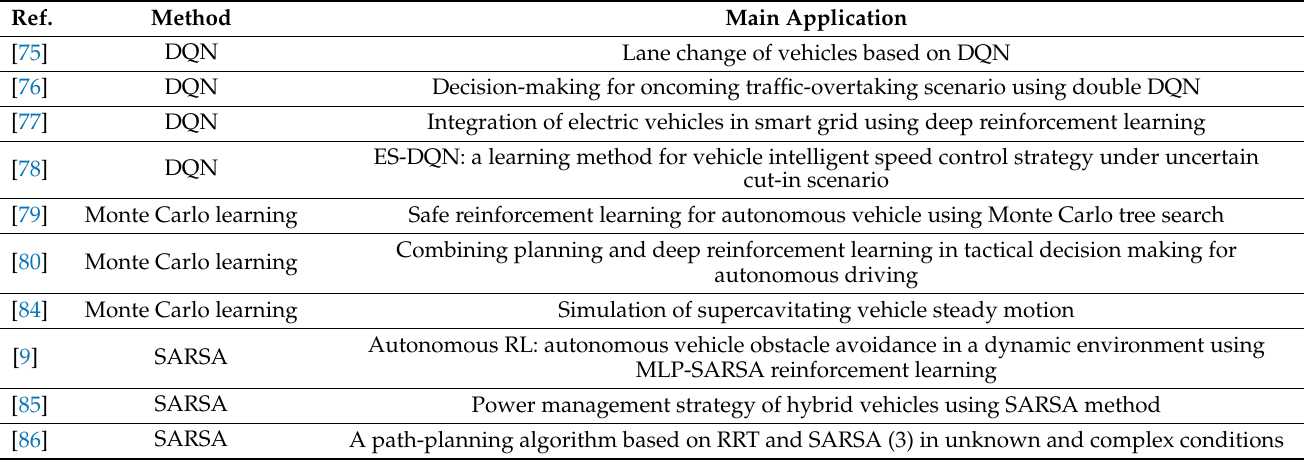
Table 3. Reinforcement